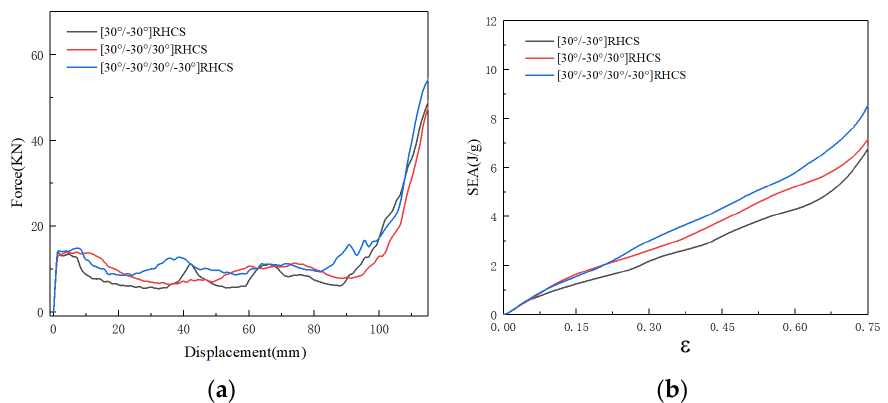
multi-layer composite RHCS improved as the number of layers increased.